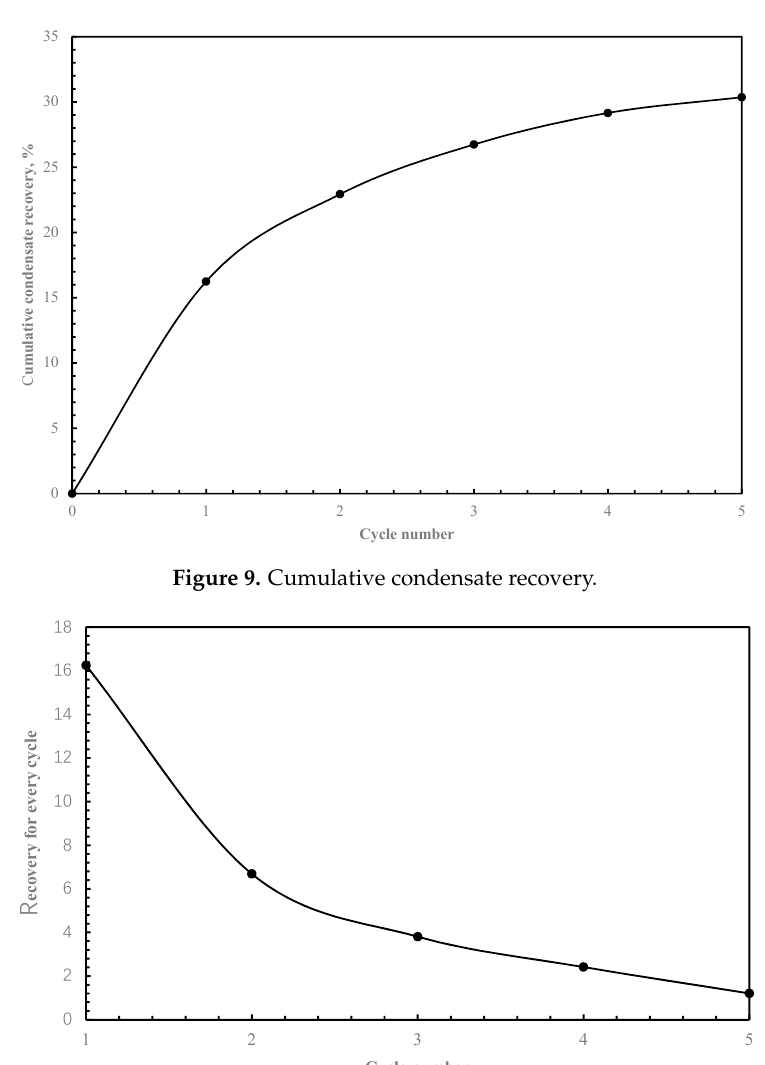
Figure 8. Variation of condensate saturation.